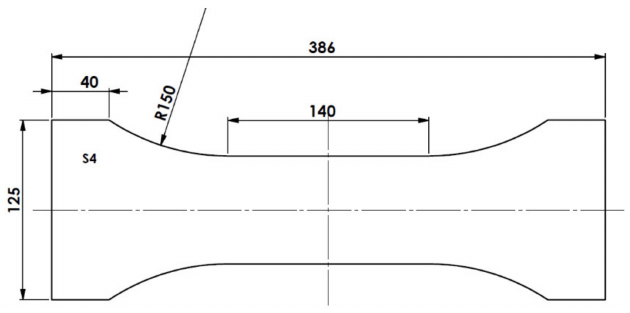
Figure 5. Layout of the plywood tensile testing sample.